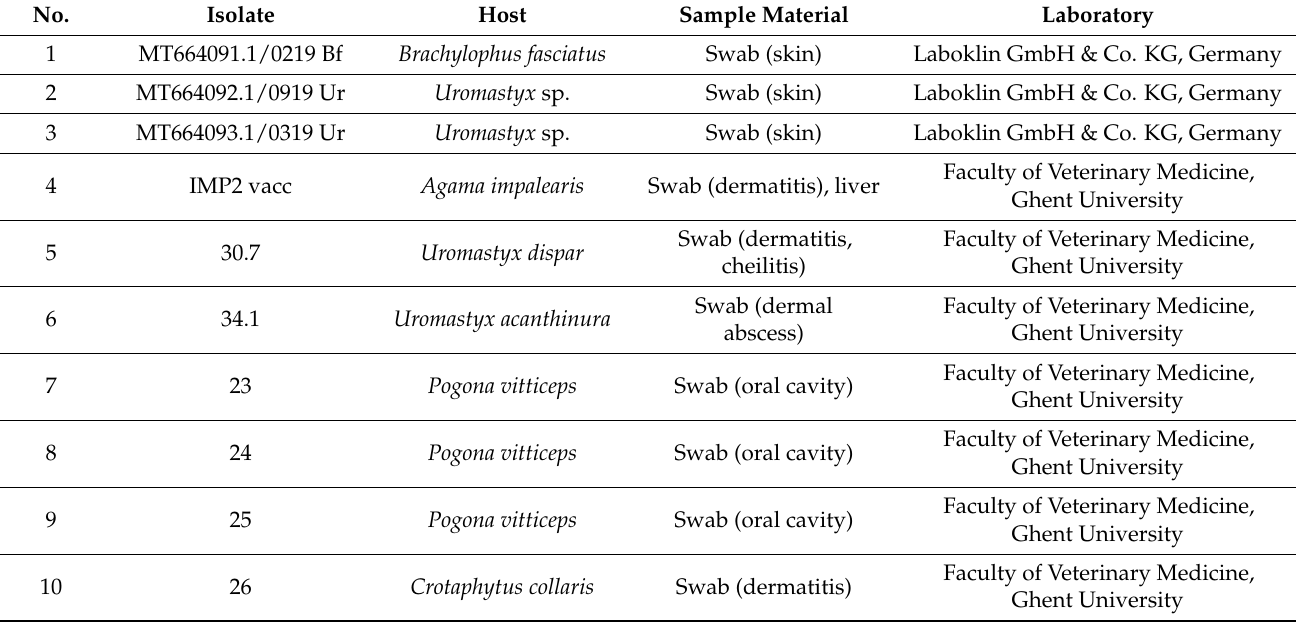
Table 1. Devriesea agamarum isolates used to establish the